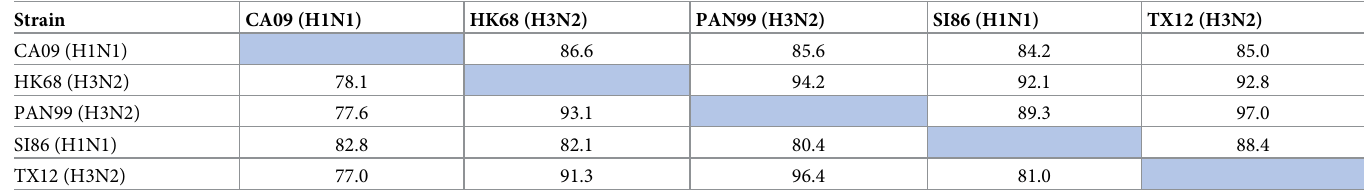
Table 2. Pairwise percent nucleotide identity among Influenza A strains used in experimental coinfections. Values above the diagonal exclude antigenic segments HA and NA which are more highly variable than the internal segments. Strain